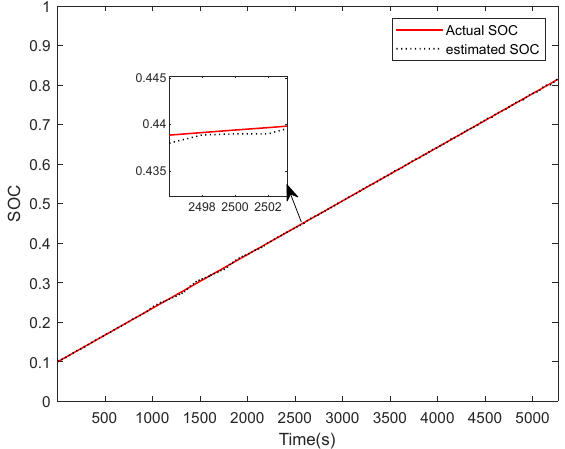
Figure 5. SOC estimation during low-current charging.